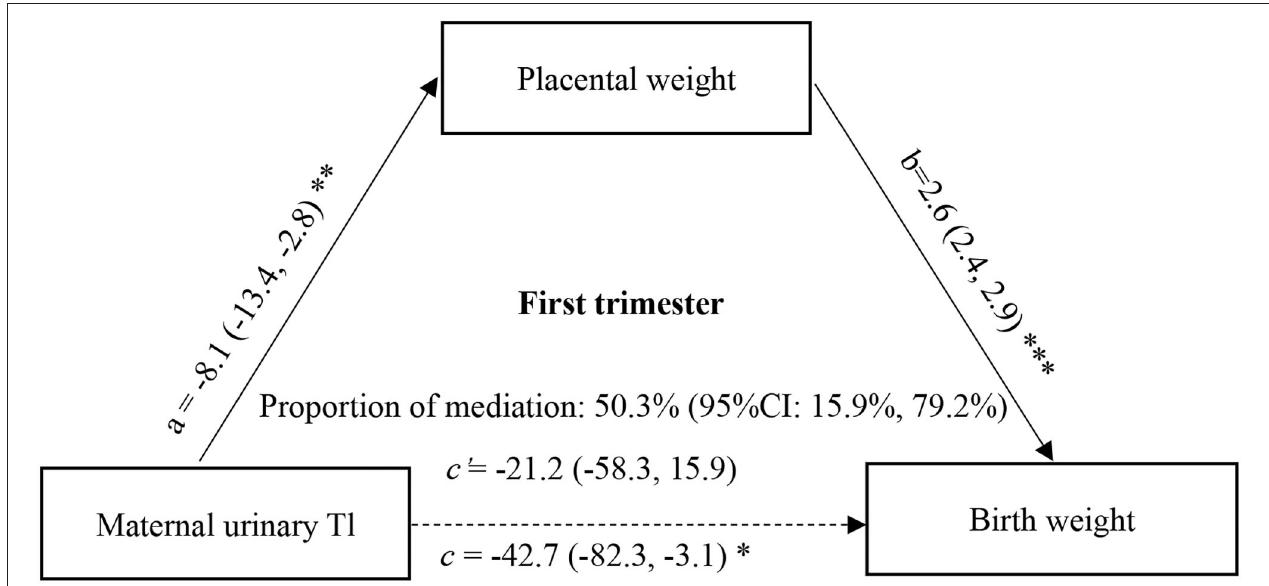
FIGURE 1 | Mediation effect of placental weight on the association of maternal urinary Tl exposure during the first trimester with birth weight. a, c, and c’ were estimated for the highest vs. the lowest tertile of ln-Tl exposure, and b was estimated for each unit increase in placental weight. All effect sizes were adjusted for final analyses: maternal age, maternal education, family income, gestational week, parity, gravidity, infant sex, vegetable consumption, fruit consumption. *** P < 0.001, ** P < 0.01, * P < 0.05.